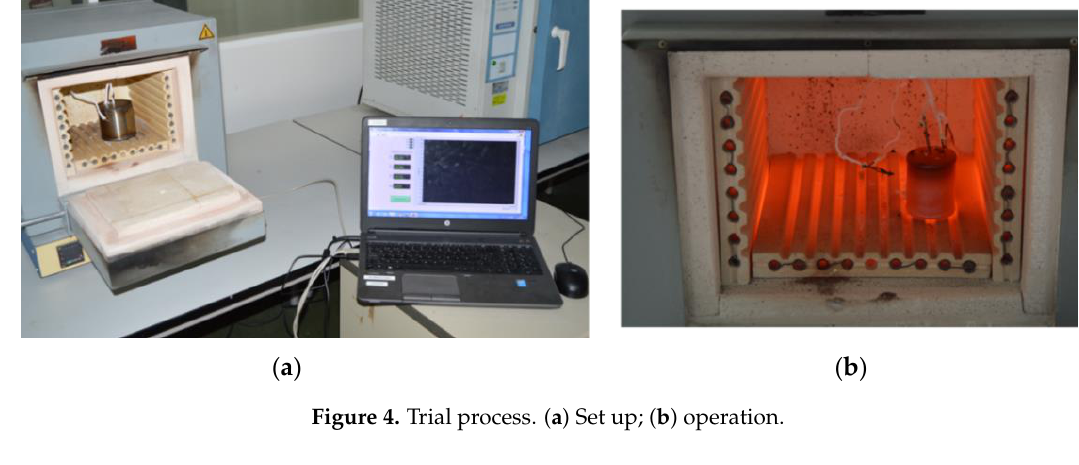
Figure 4. Trial process. ( a ) Set up; ( b ) operation.